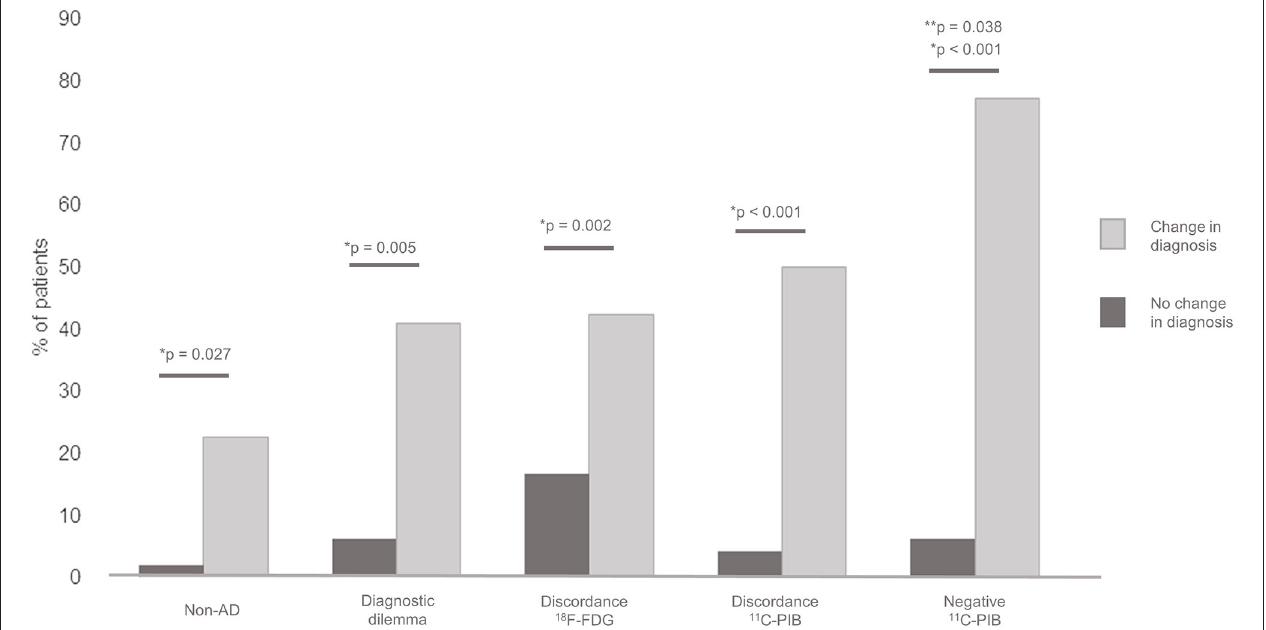
FIGURE 1 | Association between diagnostic change and baseline Non-AD diagnosis, previous diagnostic dilemma, 18 F-FDG PET discordance with baseline diagnosis, 11 C-PIB PET discordance with baseline diagnosis and negative 11 C-PIB PET result. *Individual comparison significance. **Mutivariate logistic regression significance.